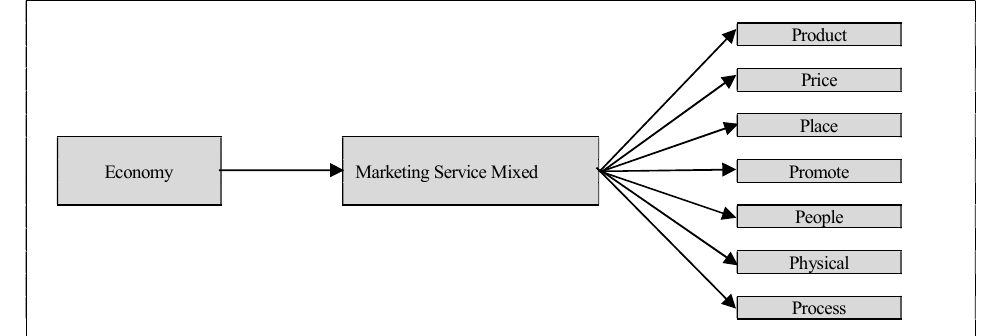
Fig. 2. Conceptual research